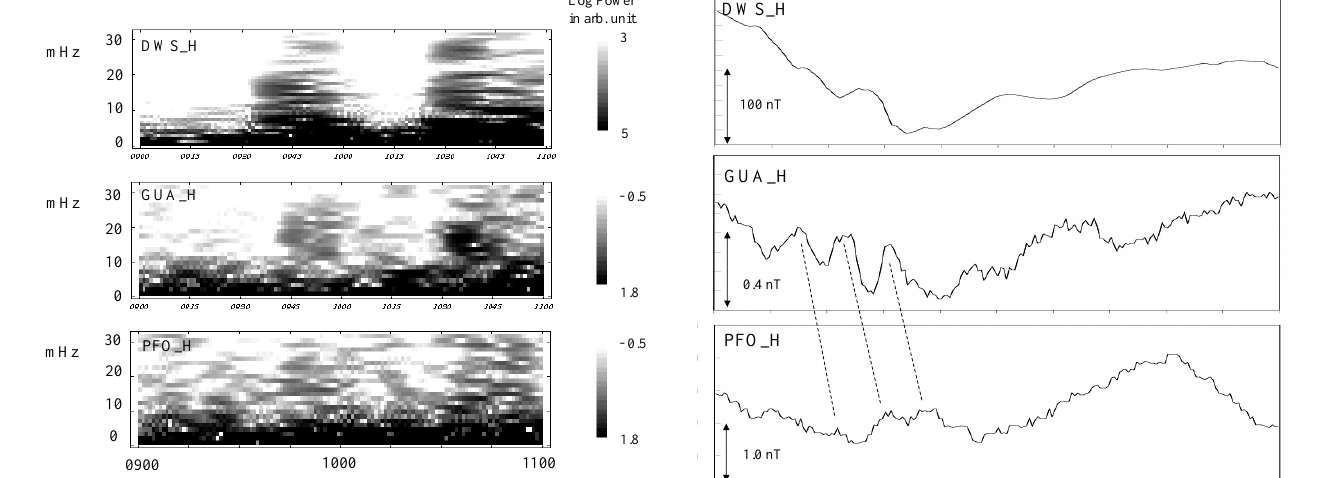
Figure 9. From top to bottom: the dynamic power spectra of H for DWS, GUA, and PFO calculated by the FFT (fast Fourier trans- form) technique. The spectral power was calculated using 256 data points (12.8min) by sliding 1min.